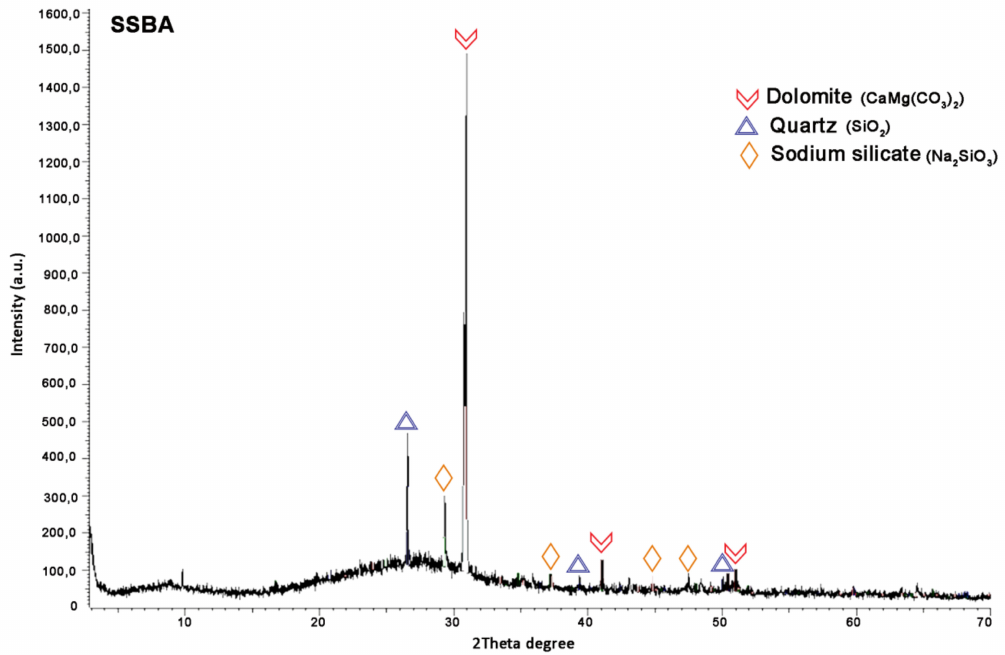
Figure 5. SSBA mineralogical composition by X-Ray di ff raction